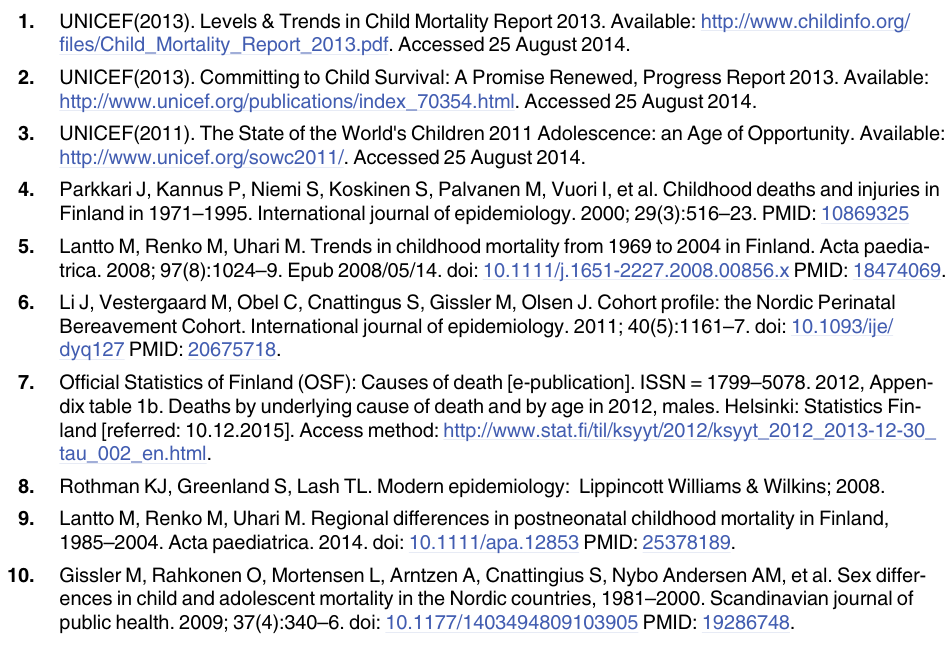
S2 Table. Mortality rate due to natural death by age, gender and calendar period. S3 Table. Mortality rate due to unnatural death by age, gender and calendar period. S4 Table. Mortality rate ration of boys to girls between 1981 – 1995 and 2001 – 2005. S5 Table. Mortality rate due to neoplasms by age, gender and calendar period. S6 Table. Mortality rate due to diseases of the nervous system by age, gender and calendar period. S7 Table. Mortality rate due to diseases of transport accidents by age, gender and calendar